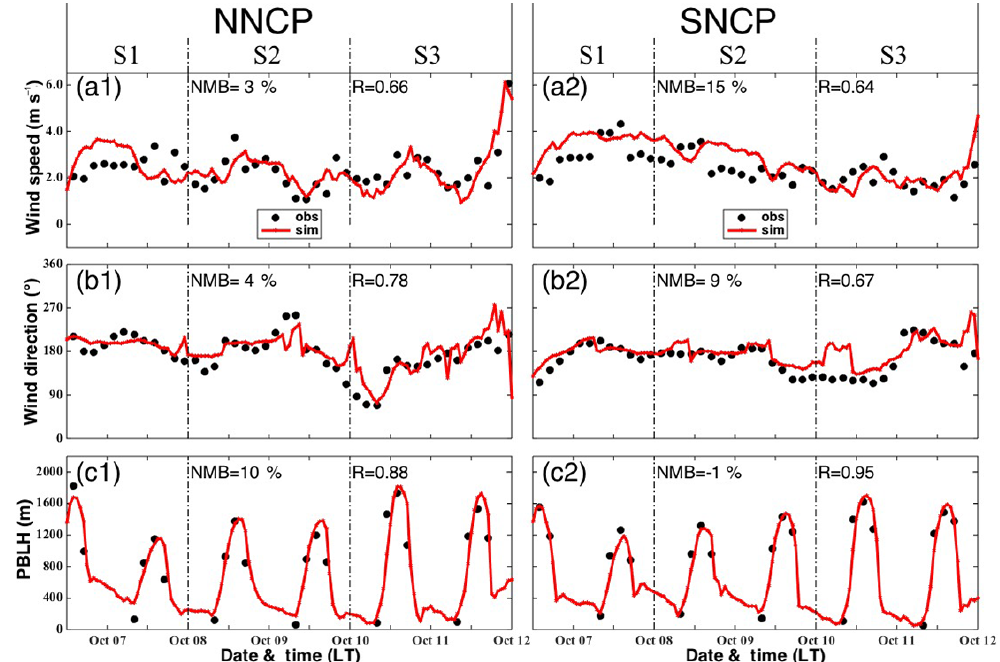
Figure 5. Regional average temporal variations in simulated (in red) and observed (in blue) results of meteorological parameters of (a) wind speed (b) wind direction and (c) PBLH over the regions of NNCP and